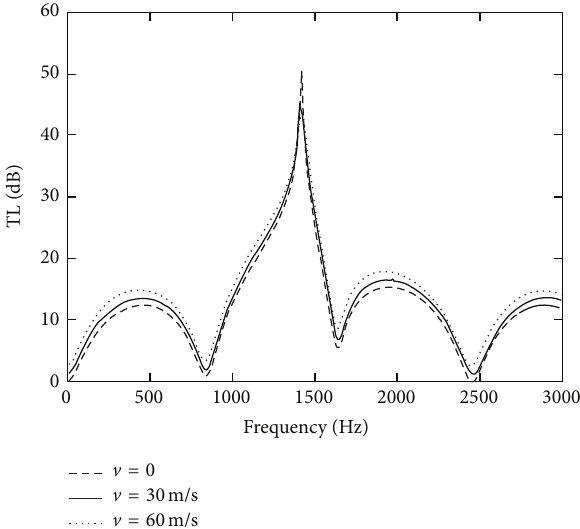
Figure 13: Effect of flow velocity on TL of the expansion chamber